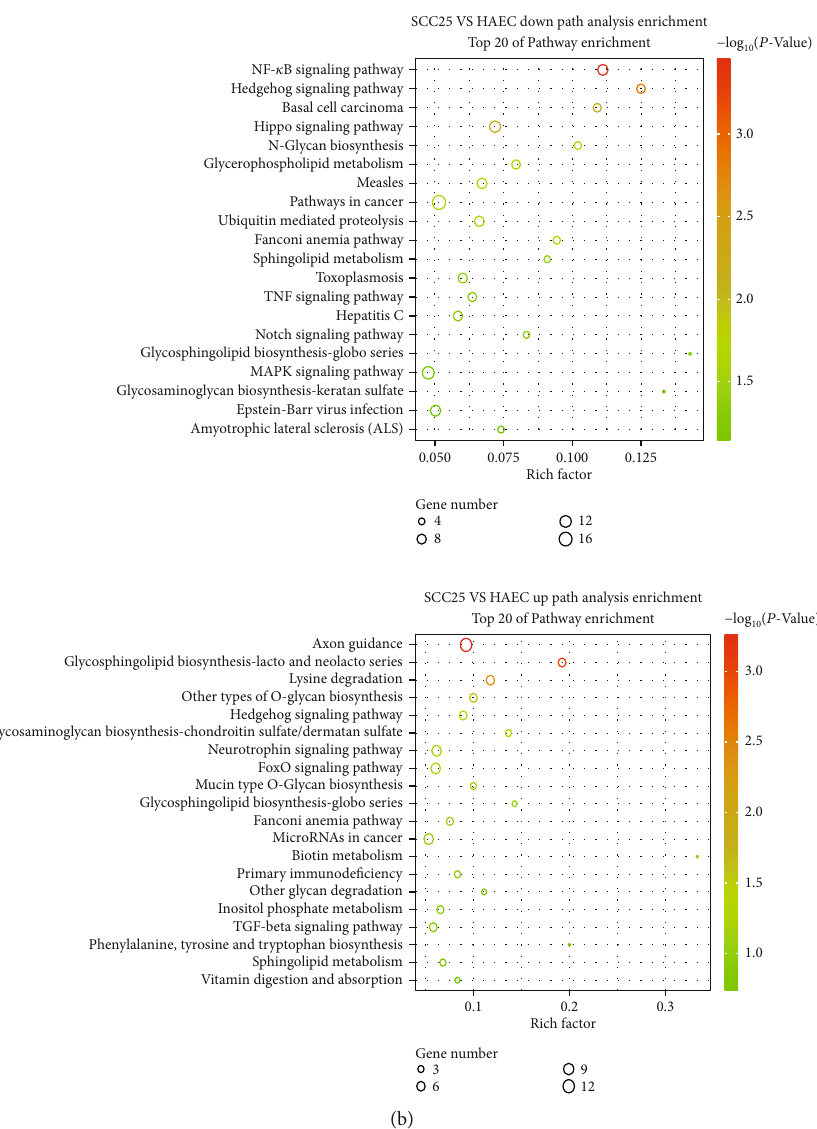
Figure 7: Pathway enrichment analysis. (a) The pathway enrichment analysis was performed to fi nd metabolic pathways that were signi fi cantly enriched in peak-neighboring genes based on the KEGG database, thereby investigating metabolic pathways that might be orchestrated by transcription factors and that might be mediated by transcription factors at di ff erent developmental stages and cell states. The pathway enrichment analysis can directly re fl ect the e ff ect of genes on phenotypes and maximize the relationship between signi fi cantly enriched metabolic pathways and phenotypes. The selected peak-neighboring genes were annotated based on the KEGG database to obtain all of the metabolic pathways in which peak-neighboring genes were involved. All of the peak-neighboring genes were assigned to di ff erent metabolic pathways. Fisher ’ s exact test was used to calculate the signi fi cance of gene enrichment in each pathway. In order to screen out the metabolic pathways that were signi fi cantly enriched in peak-neighboring genes, the top 15 entries were chosen in the pathway enrich analysis where peak-neighboring genes were signi fi cantly enriched as the horizontal axis histogram. The horizontal axis in the histogram was employed to show -log10 ( P value), and the vertical axis was the pathway name. Meanwhile, the top 25 entries were selected in the pathway enrich analysis in which peak-neighboring genes were signi fi cantly enriched as a vertical axis histogram. In the histogram, the horizontal axis showed the pathway name, and the vertical axis represented enrichment. In all charts, red represented signi fi cant items, and blue marked nonsigni fi cant items. (b) The results of the pathway enrichment analysis of peak-neighboring genes were presented in a bubble chart. The top 20 pathway entries were selected, in which peak-neighboring genes were signi fi cantly enriched for displaying. The ordinate in the fi gure stood for the pathway entry, and the abscissa indicated the rich factor. The size of the dot in the fi gure indicated the number of peak-neighbor genes enriched on the pathway entry, and the color represented the signi fi cance P value of the pathway entry. The smaller the P value, the more signi fi cant the set. The pathway enrichment degree was measured using the rich factor, P value, and the number of genes enriched in this pathway entry. Among them, the rich factor referred to the ratio of the number of peak-neighbor genes enriched in the pathway entry to the number of all genes annotated to the pathway entry. The greater the rich factor, the greater the degree of